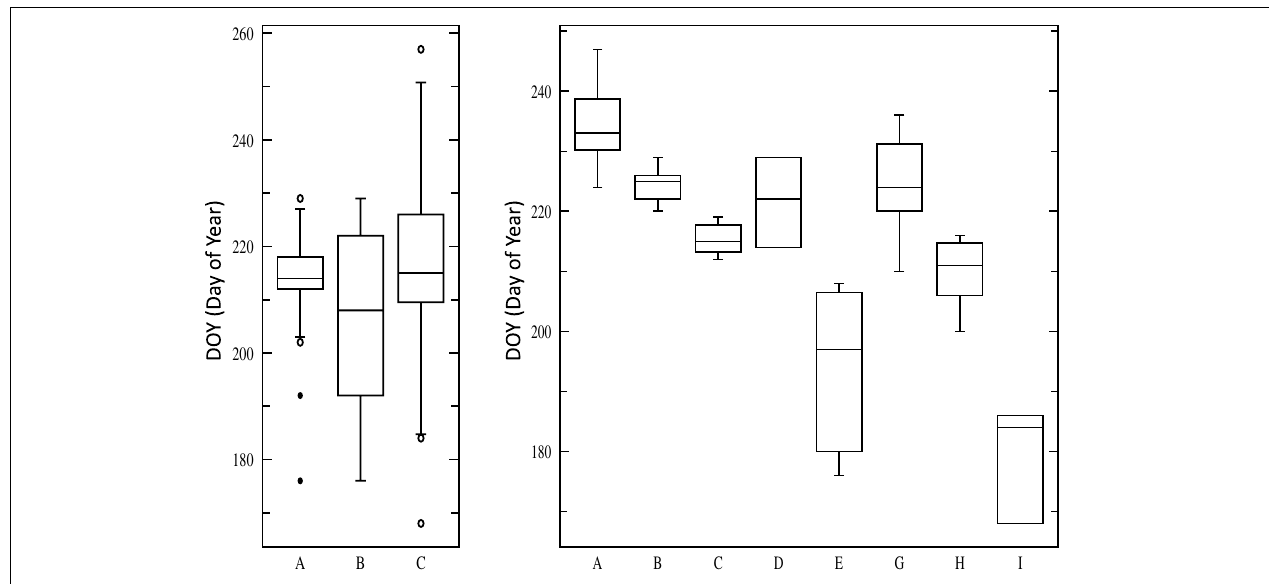
FIGURE 2 |ANOVA (Analysis ofVariance) of heading date for 113 switchgrass germplasms. Left: three groups based upon cytotype and ploidy (Lowland4 × , Upland4 × , Upland8 × ). Right: eight groups based upon cytotype, ploidy, and morphological